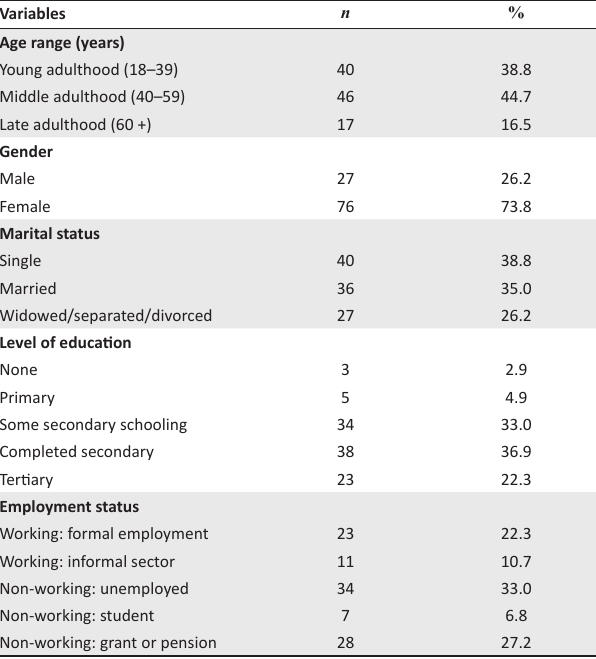
TABLE 1: Demographic information of the study sample ( n = 103).